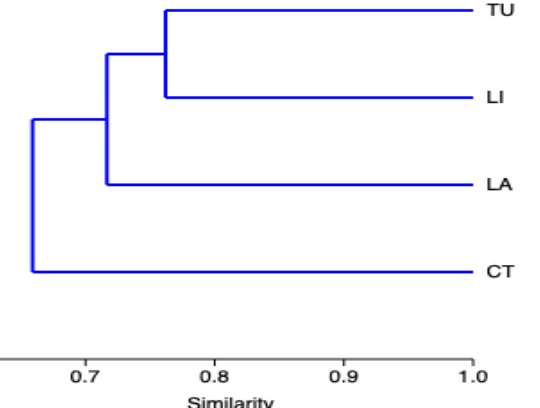
Figure 5. Cluster analyses. The greatest similarity occurs for populations whose values are close to